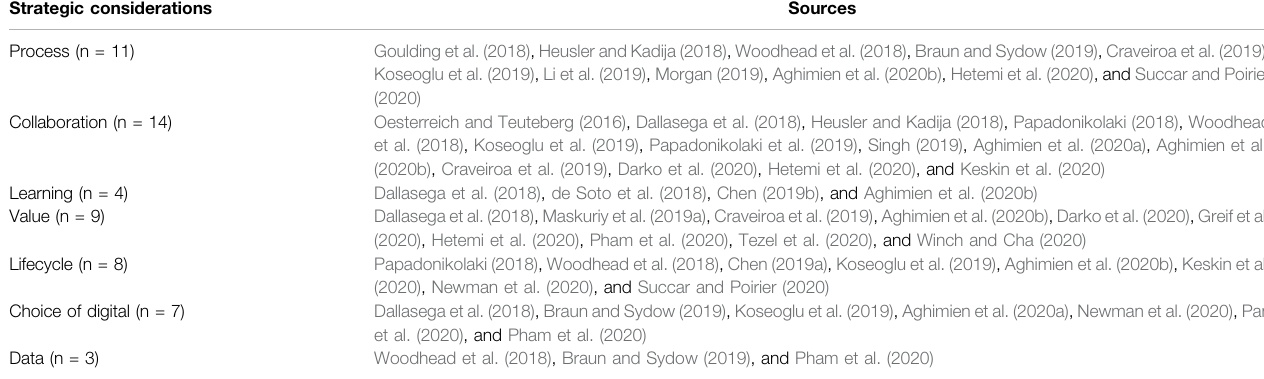
TABLE 3 | Summary of literature on strategic